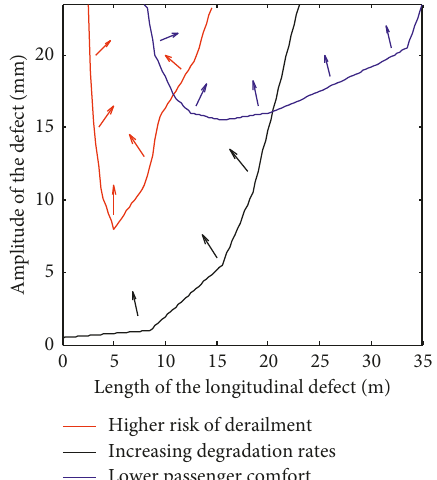
Figure 7: Identification of the regions that negatively affect the track performance, analysed in terms of amplitude and length of the defects: (i) regions with higher risk of derailment (lower train running safety) in red, (ii) regions with increasing track degradation rates in black, and (iii) region with lower passenger ride comfort in blue (adapted from [25]).